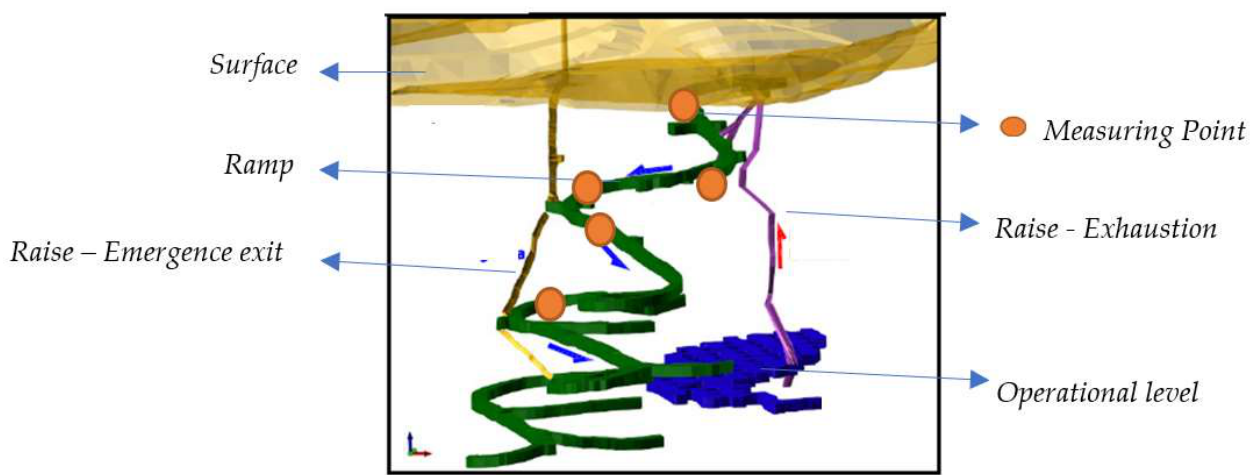
Figure 2. 3D underground mine map showing the monitoring points.